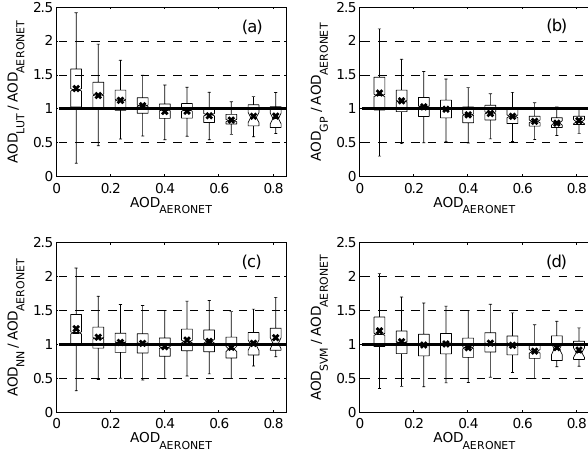
Figure 2. Differences between predicted and observed (AERONET) AOD for the methods: (a) LUT (look-up table), (b) GP (Gaussian process), (c) NN (neural network) and (d) SVM (support vector machine) with respect to the observed AOD. The crosses indicate the means of each subgroup, the limits of the boxes are 25, 50 and 75% of the data, and the lines are plotted with 1.5 times the interquartile ranges.